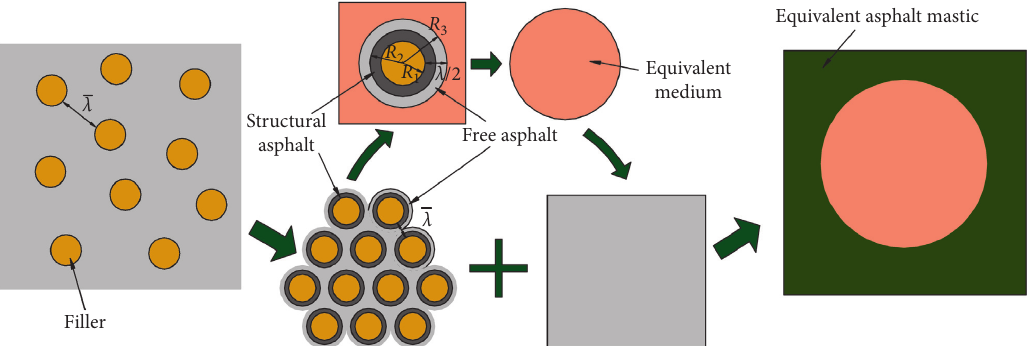
Figure 4: Modified H-MRP